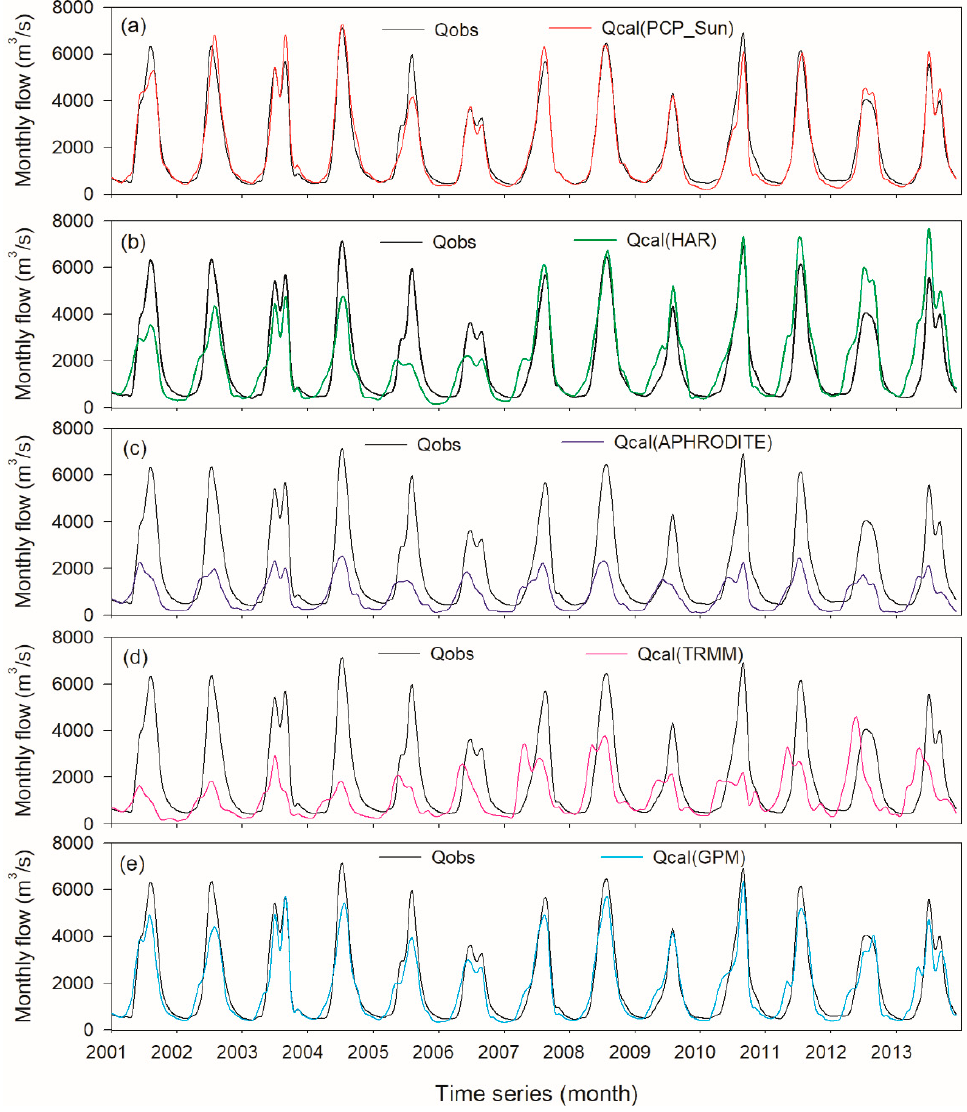
Figure 10. Monthly flow simulation driven by ( a ) reference precipitation and four precipitation datasets: ( b ) HAR, ( c ) APHRODITE, ( d ) TRMM and ( e ) GPM, at Nuxia hydrological station during years 2001–2013.